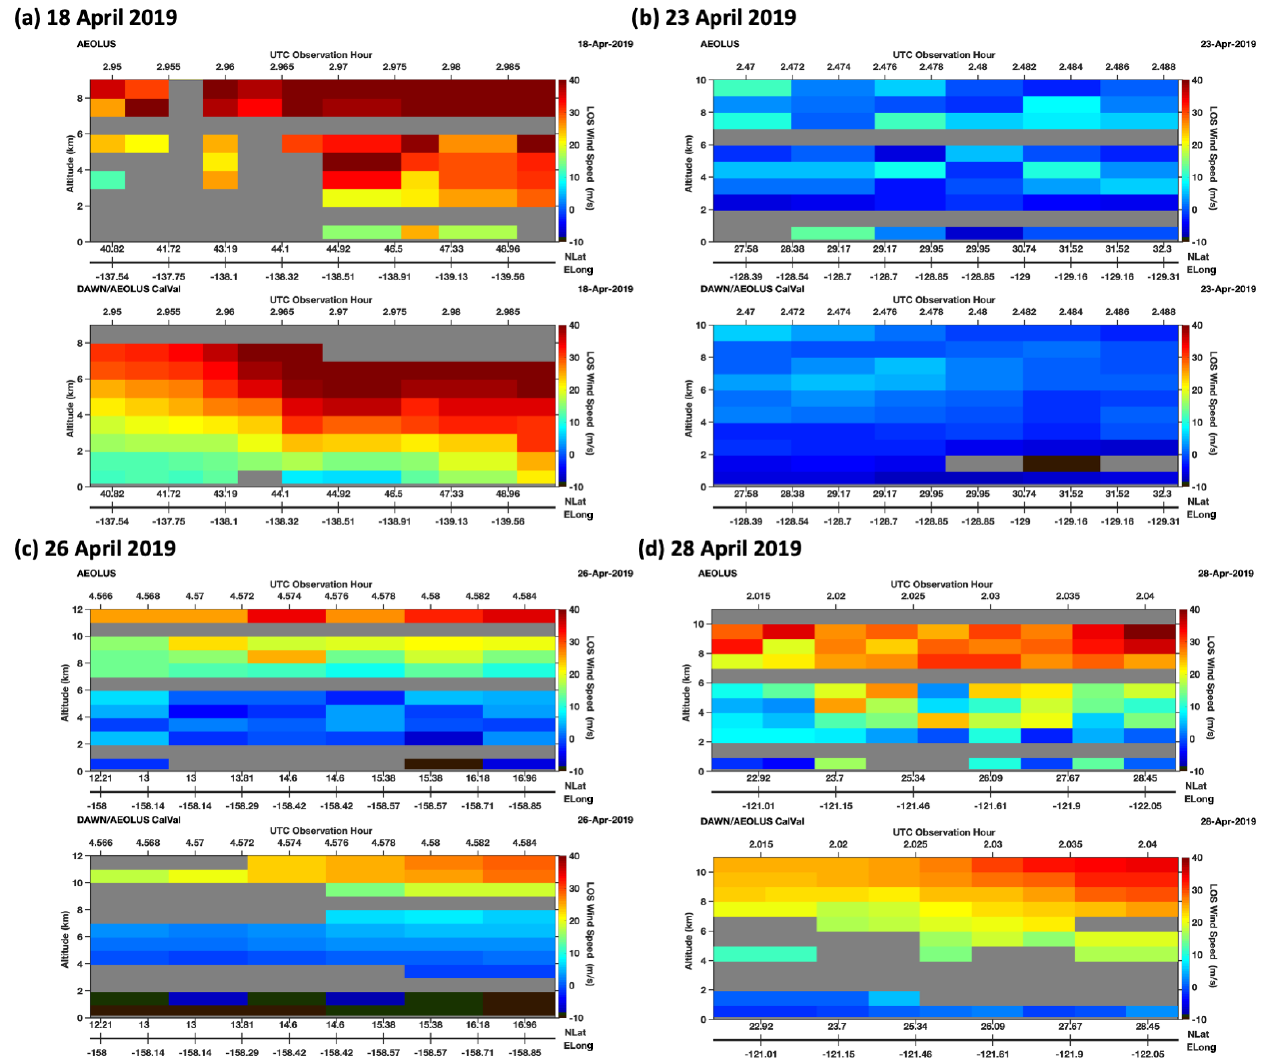
Figure 17. Aeolus Rayleigh clear (a, b) and the mean DAWN HLOS speed aggregated across 90km Rayleigh clear integration distances (c, d) , analogous to Fig. 16a and b, for the four remaining Aeolus